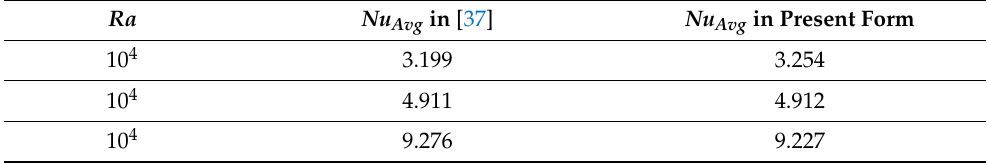
Table 1. A comparison of the average Nusselt number at three different meshing levels against Ra